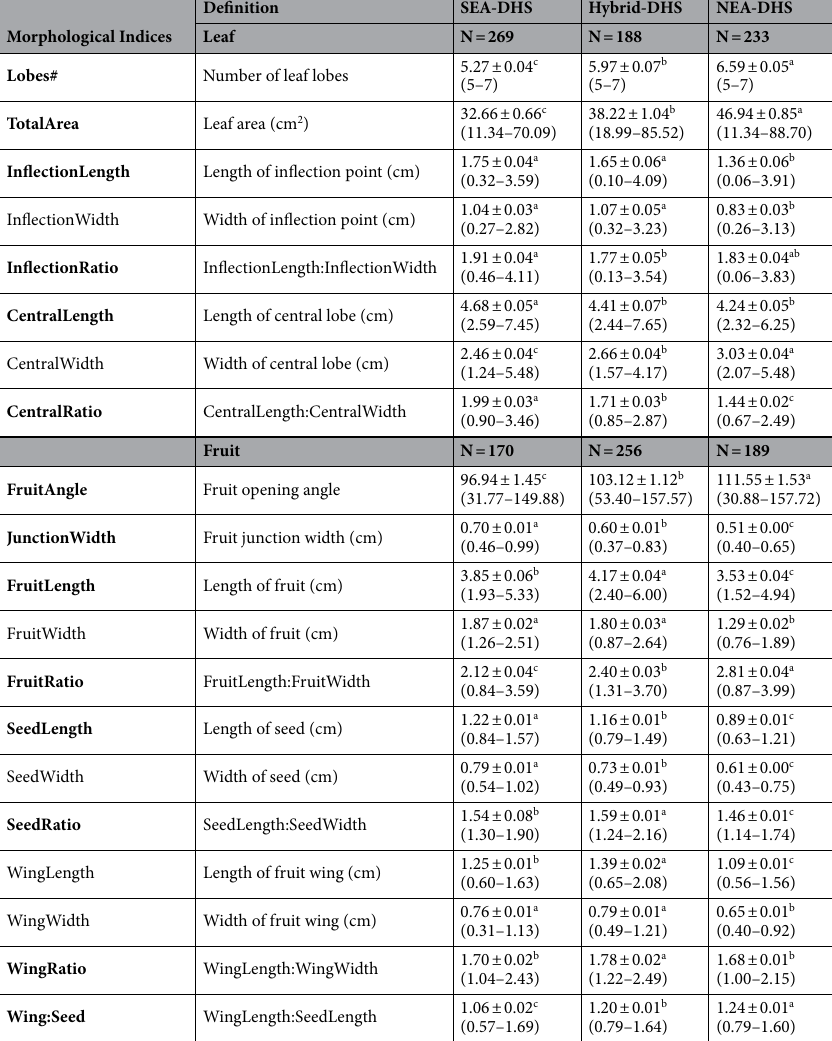
Table 2. Morphological variation in the leaves and fruits of Acer trees in the Daheishan National Nature Reserve. Definitions of morphological indices were presented in Supplementary Fig. S5. The results show the average value ± standard error (minimum–maximum value). Significant differences between pairs determined at the p < 0.05 level based a one-way ANOVA are indicated by different superscript letters. Bold indicators were used for subsequent principal component analysis. SEA-DHS Southern East Asia lineage of the Acer species complex in the Daheishan National Nature Reserve (DHS), NEA-DHS Northern East Asia lineage of the Acer species complex in the DHS, Hybrid-DHS hybrids between SEA-DHS and NEA-DHS